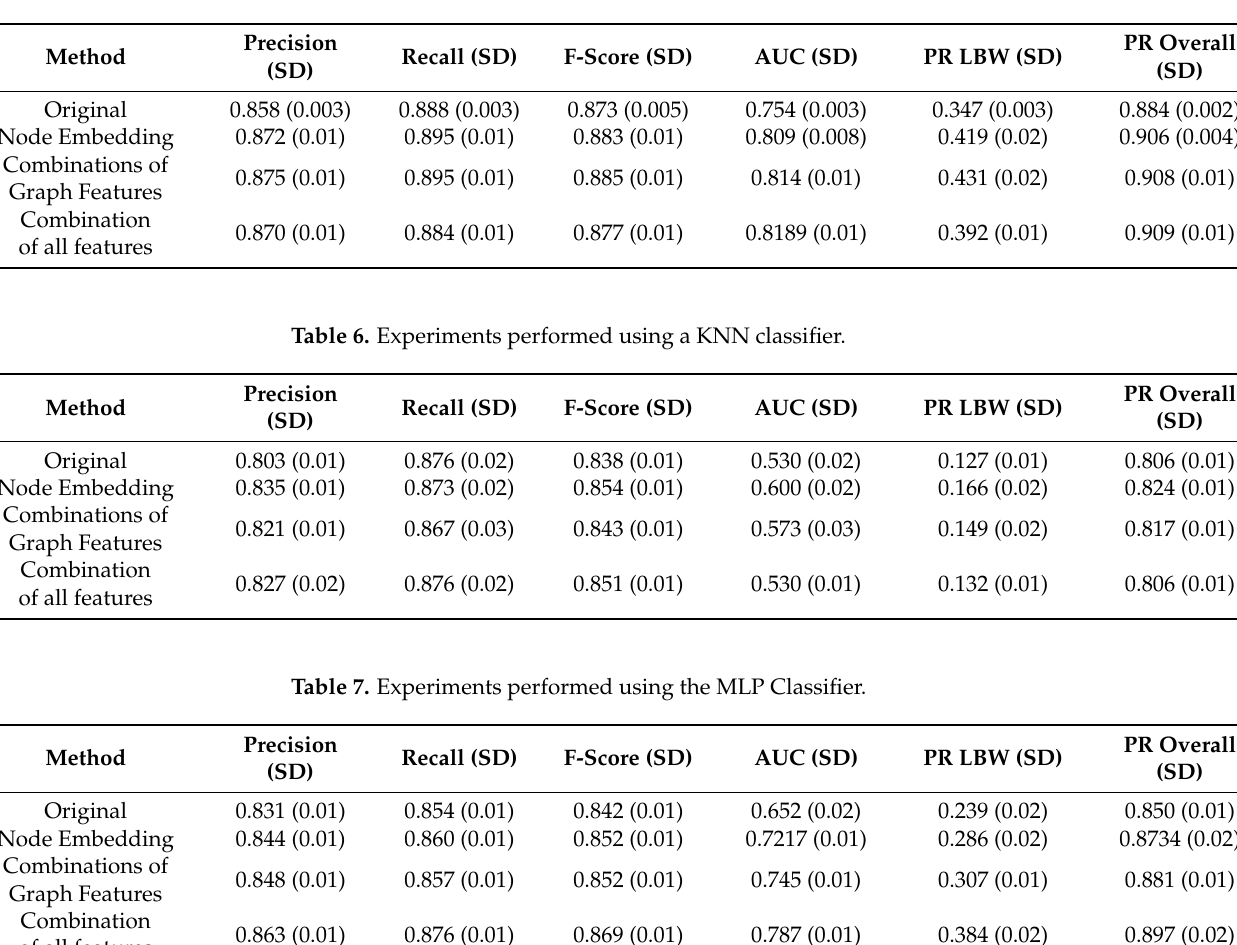
Table 5. Experiments performed using a logistic regression classifier.